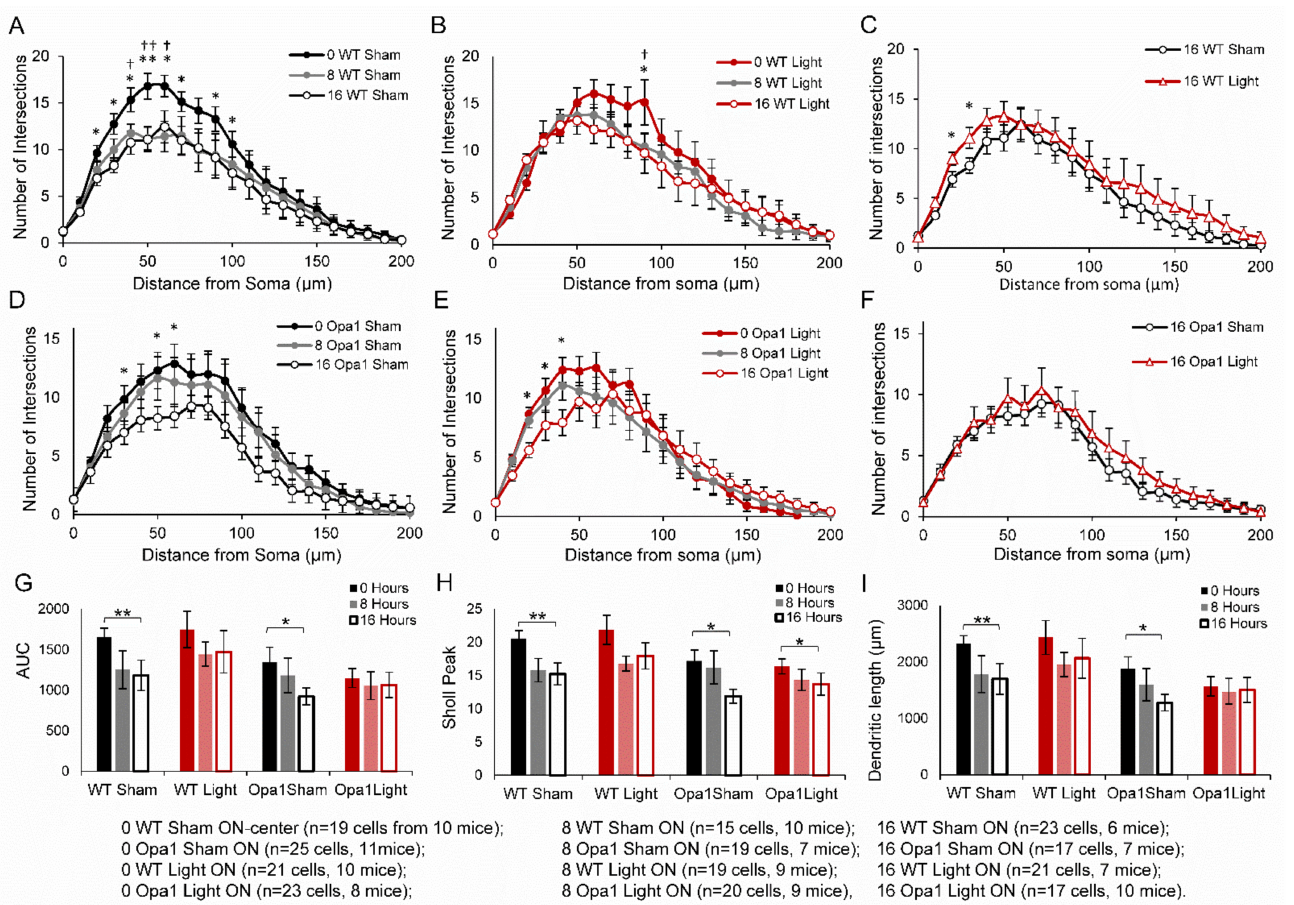
Figure 3. Sham-treated aged ON-center WT and Opa1 +/ − RGCs exhibited significant axotomy-dendropathy while light- treated RGCs did not. ( A ) There was significant degeneration at multiple points along the Sholl curve for sham-treated WT RGCs at 8- and 16-h ex vivo post axotomy in sham-treated WT RGCs. ( B ) Sholl profiles from light-treated ON-center RGCs revealed a significant degeneration at 90 µ m at 16 h post axotomy. ( C ) Direct comparison of the 16-h sham- and light-treated RGC Sholl curves showed a greater number of dendritic intersections at 20 and 30 µ m in the light-treated group. ( D ) Sham- and ( E ) light-treated Opa1 +/ − RGC Sholl profiles showed degeneration after 16 h ex vivo. ( F ) Sholl profiles comparing the sham- and light-treated ON-center Opa1 RGCs after 16 h ex vivo revealed no effect of light treatment. Quantification of RGC dendritic complexity by ( G ) the area under the Sholl curve (AUC), ( H ) average maximum peak of Sholl curve, and ( I ) average total dendritic length all revealed significant degeneration in the retinal explants of both sham-treated groups over 16 h. Light-treated WT cells did not exhibit significant degeneration, but the maximum Sholl peak was reduced in the light-treated Opa1 group. Daggers and stars indicate a statistically significant reduction in the number of dendritic intersections from 0 h to 8- and 16-h, respectively. * p < 0.05, ** p < 0.01, † p < 0.05, †† p < 0.01; Mann-Whitney U test. Error bars represent